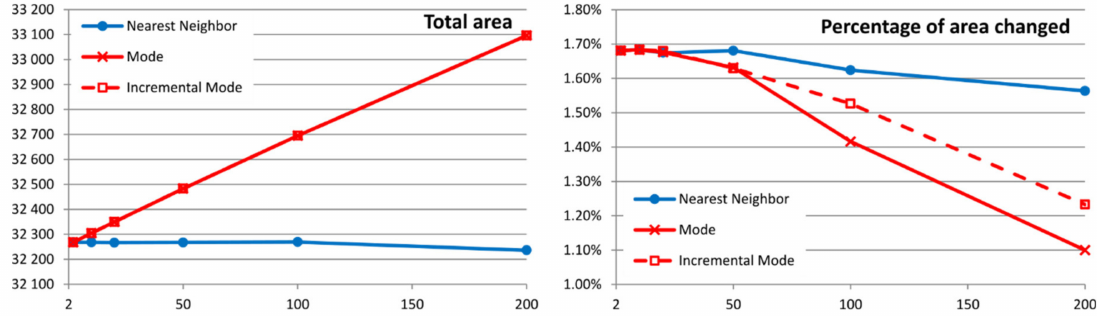
Figure 6. Total area and percentage of the area changed in the land cover change map in the Mass í s del Montseny protected area when resampling at several resolutions using di ff erent methods. Not only is the percentage of the area changed relevant, but also the nature of the changes.